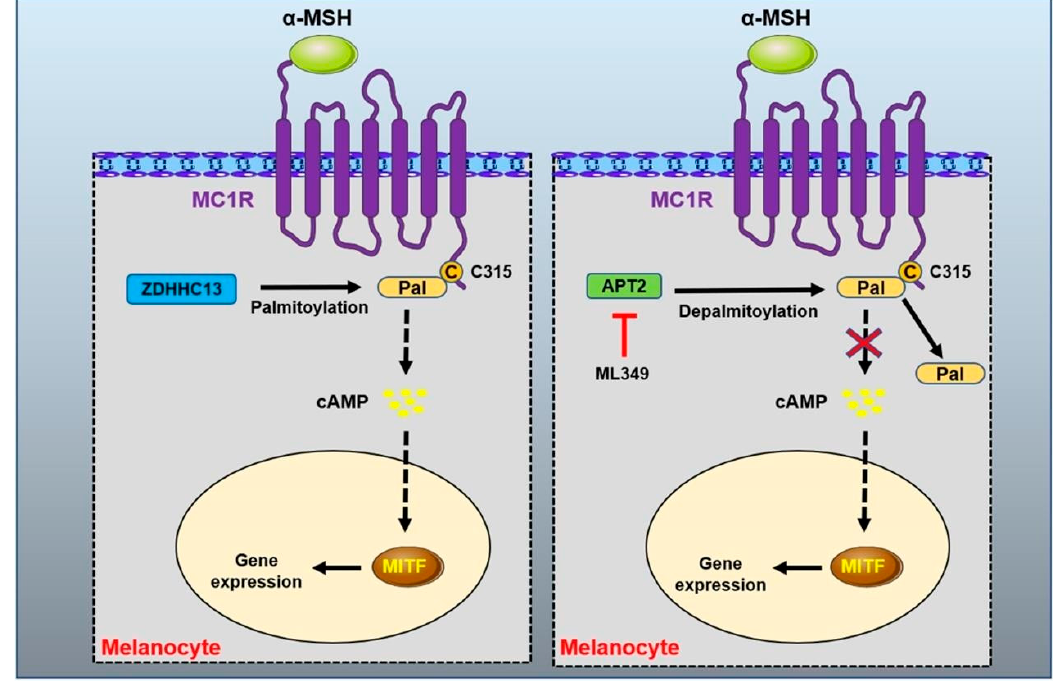
Figure 6. Palmitoyl modification of MC1R. The protein acyltransferase ZDHHC13 mediates the palmitoylation modification at cysteine 315 site of MC1R protein to activate MC1R signal. APT2 identified as MC1R depalmitoylase, and the treatment of APT2 inhibitor ML349 can effectively increase MC1R signal transduction and inhibit UVB-induced melanoma.